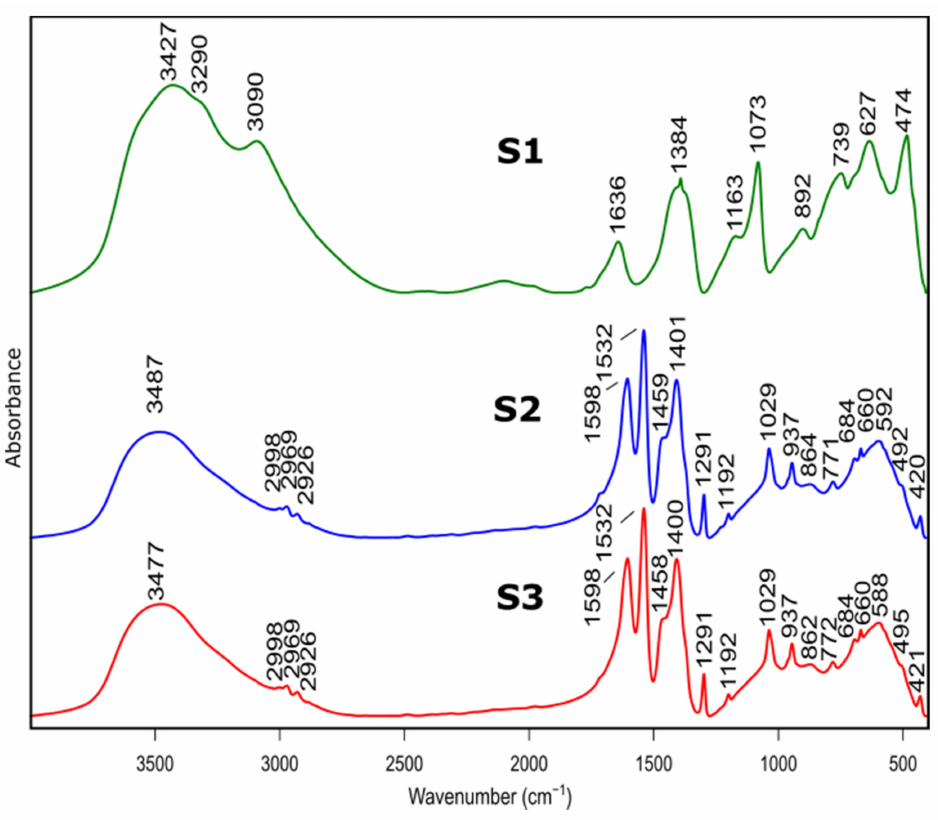
Figure 2. FTIR spectra of as prepared samples S1, S2, S3 before heat treatment.